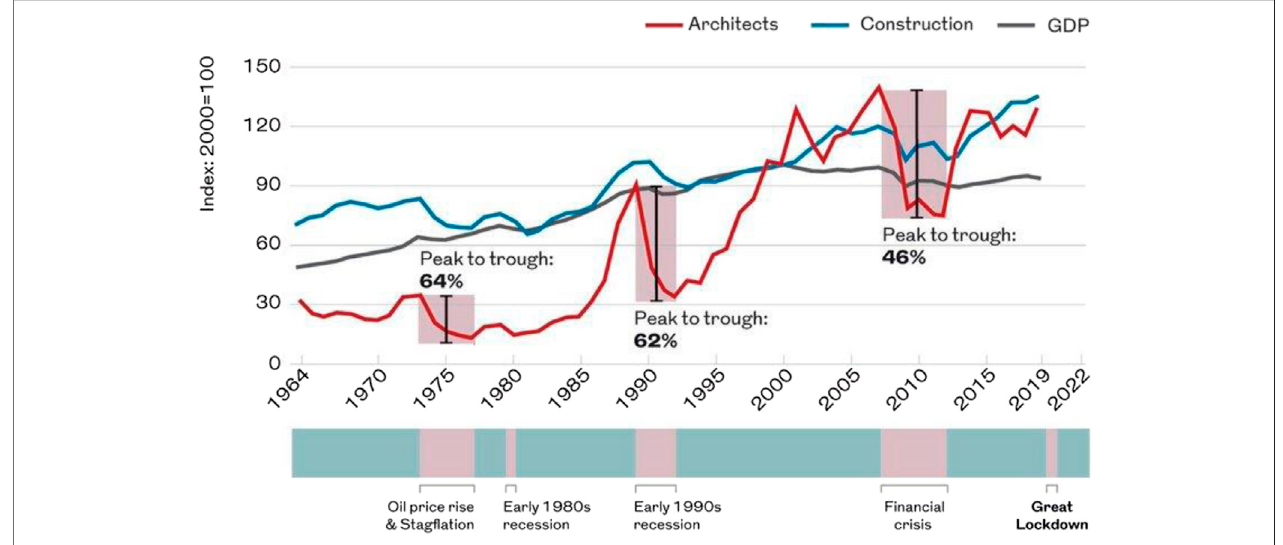
FIGURE 1 | Architects ’ workloads and construction output compared with annual GDP. © The Fees Bureau Reprinted from Mirza (2020).